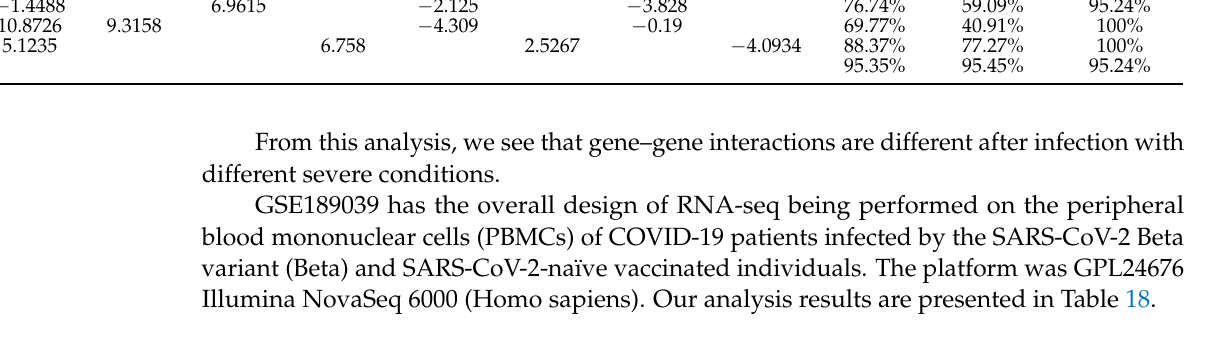
Table 18. GSE189039: Characteristics of the top-performing three-gene classifier CF1 for data of COVID-19 vs. healthy